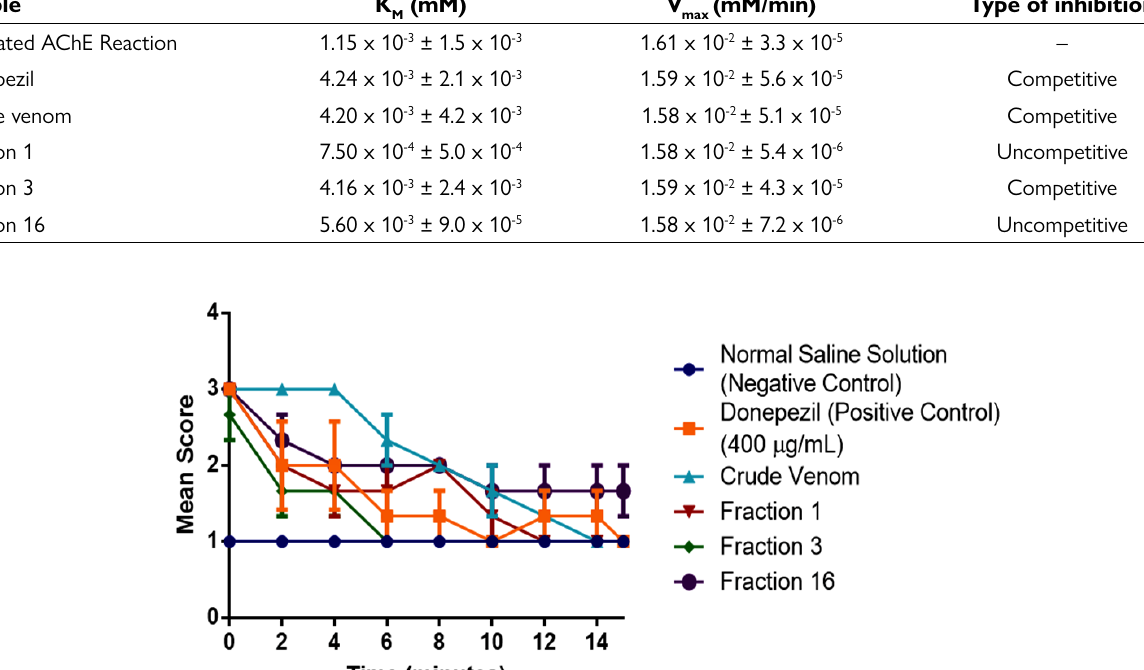
Table 1. Results of inhibition of venom fractions 1, 3, 16 and whole venom to AChE in comparison with Donepezil and untreated AChE reaction. Data is reported as mean ± SEM. Note: *p < 0.05 significant difference against the negative control value (untreated AChE reaction) (n = 3) (p = 0.0008). Sample